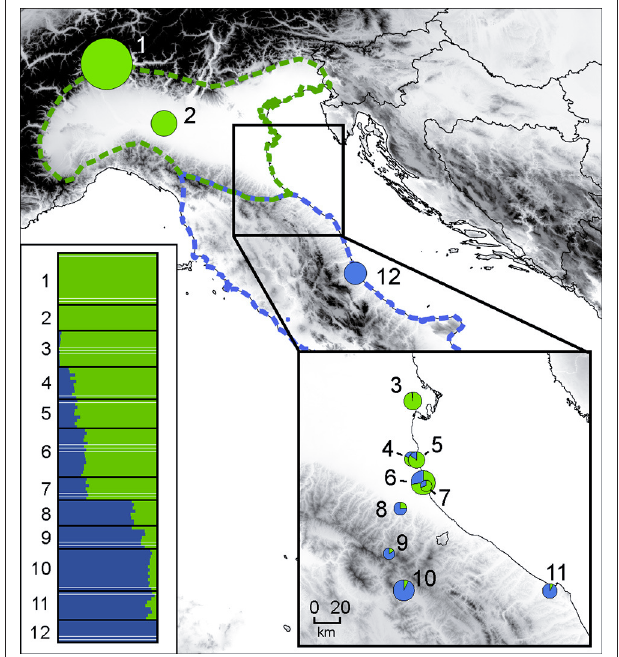
FIGURE 4 | Genetic structure across the H. perrini sp. nov. / H. intermedia s. s. transect, inferred from Bayesian clustering of individuals ( n 120 from 12 = populations) in k 2 groups (STRUCTURE), based on 2,431 loci. Horizontal = barplots show individuals assignments to the H. perrini sp. nov. (green) or H. intermedia s. s. (blue) gene pools; pie charts feature the population averages, with size proportional to sample size. The map was built in QGIS 2.18 using map layers from ESRI.